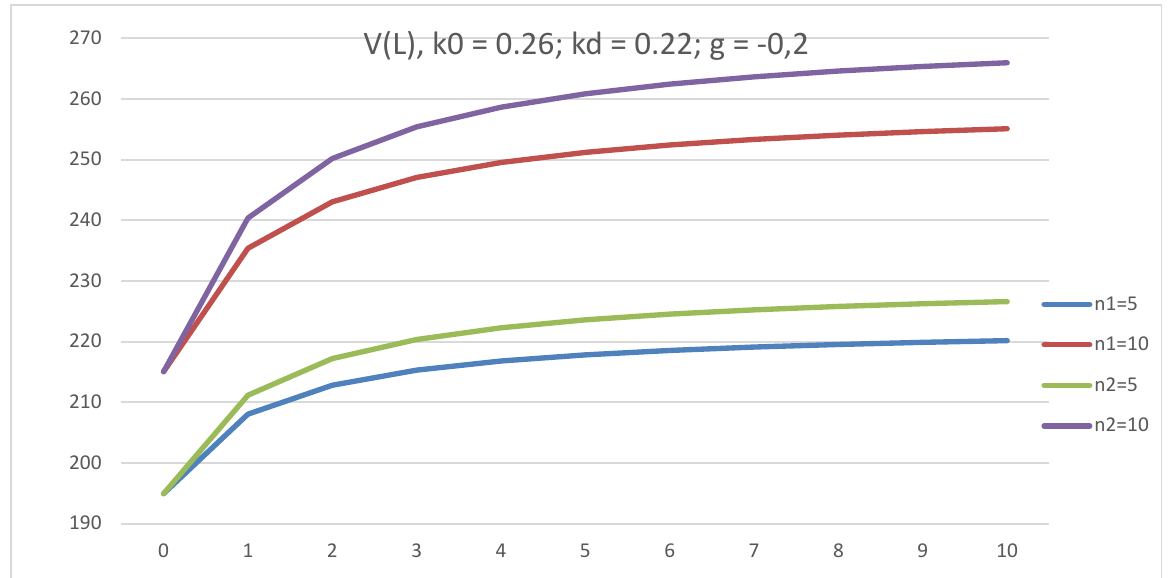
Figure 13. The dependence of company value, V, on leverage level, L, in GBFO theory with payments of tax on profit at the end of periods (1) and advance payments (2) at k 0 = 0.26; k d = 0.22; t = 0.2; g = − 0.2, for five-year and ten-year companies.